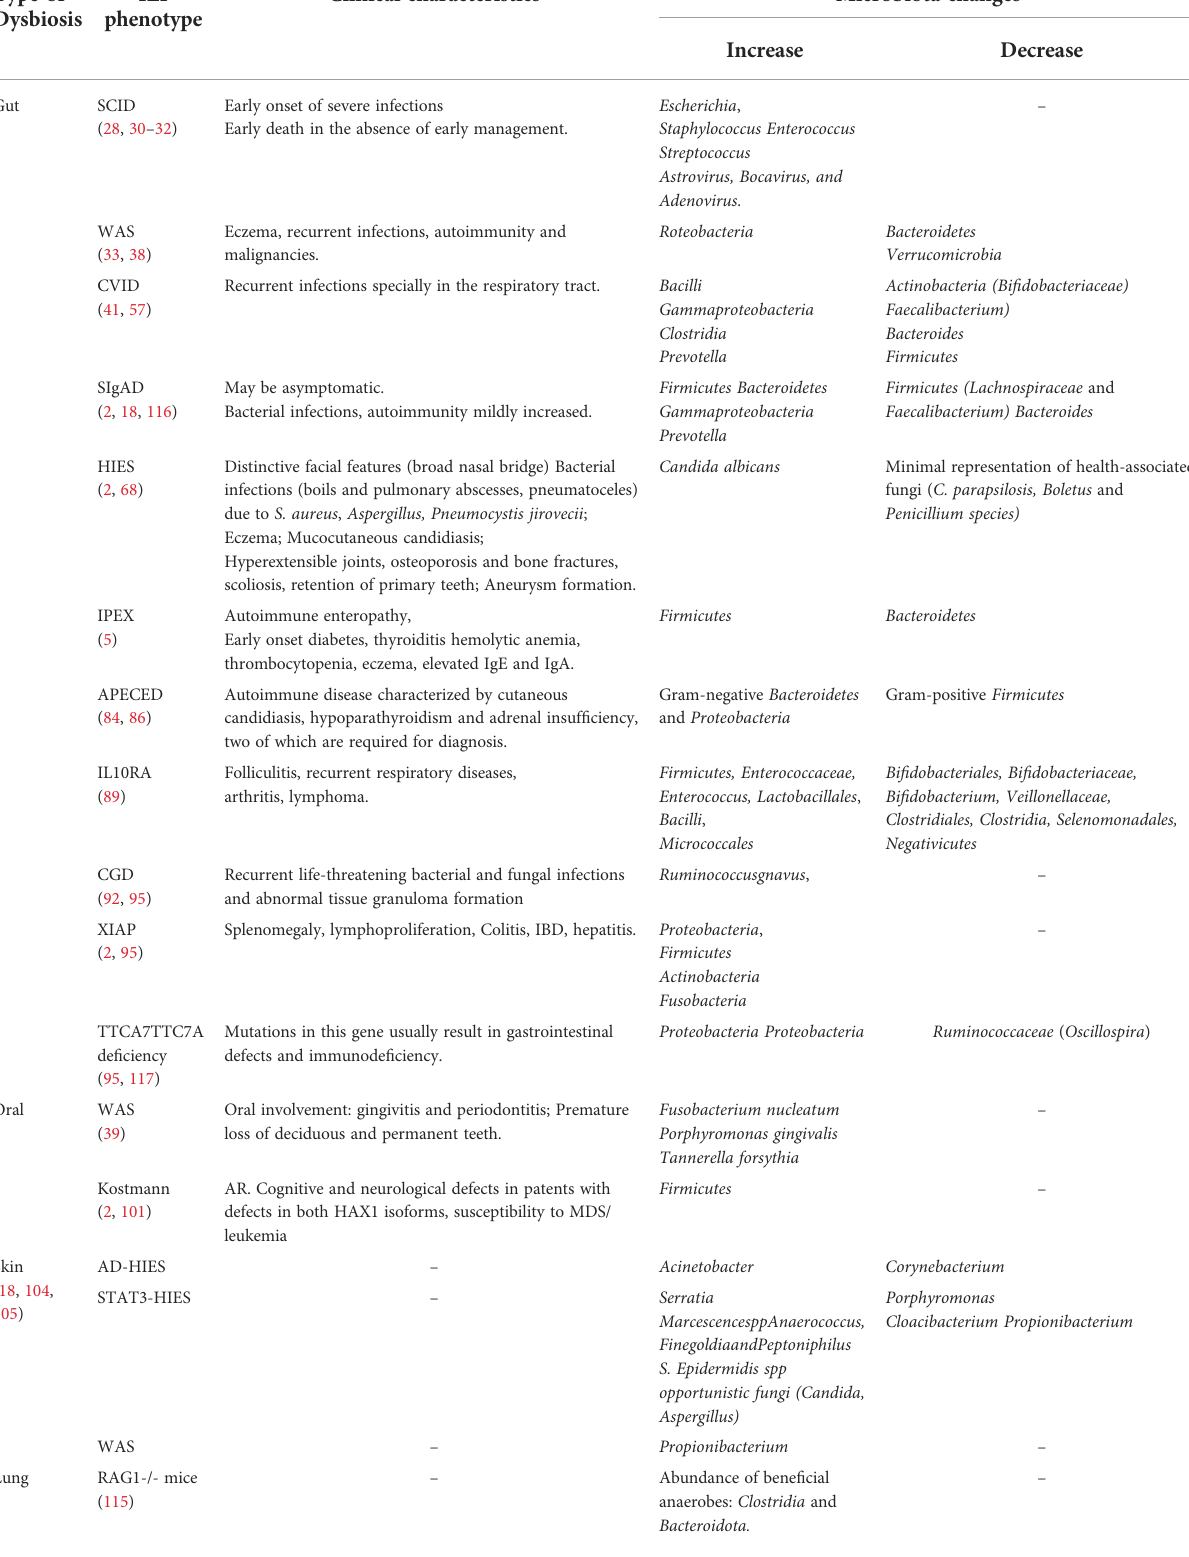
TABLE 1 Dysbiosis categories and changes associated with IEI clinical